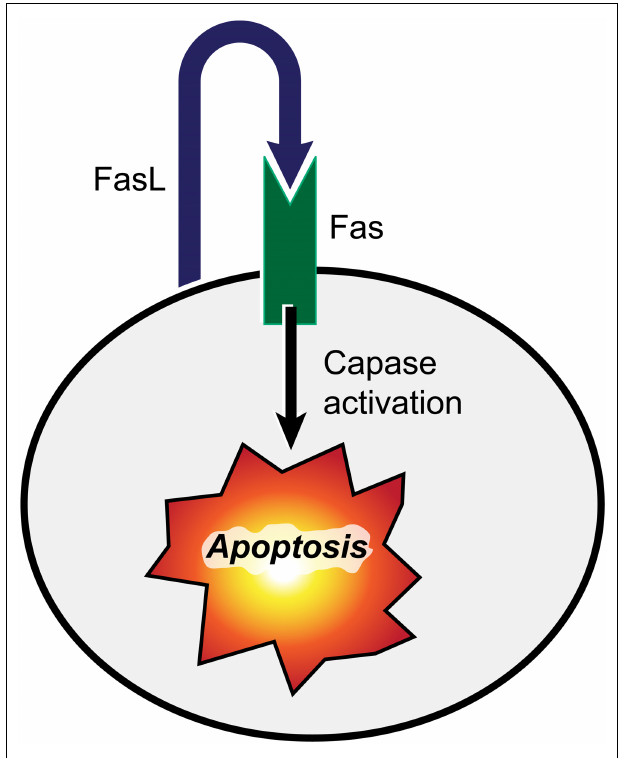
FIGURE 2 | FasL interaction with its receptor (Fas) triggers cell death. Binding of FasL to Fas induces the apoptosis of Fas-bearing cells by activation of the caspase signaling cascade leading to cleavage of nuclear DNA and proteolysis of vital cellular proteins.